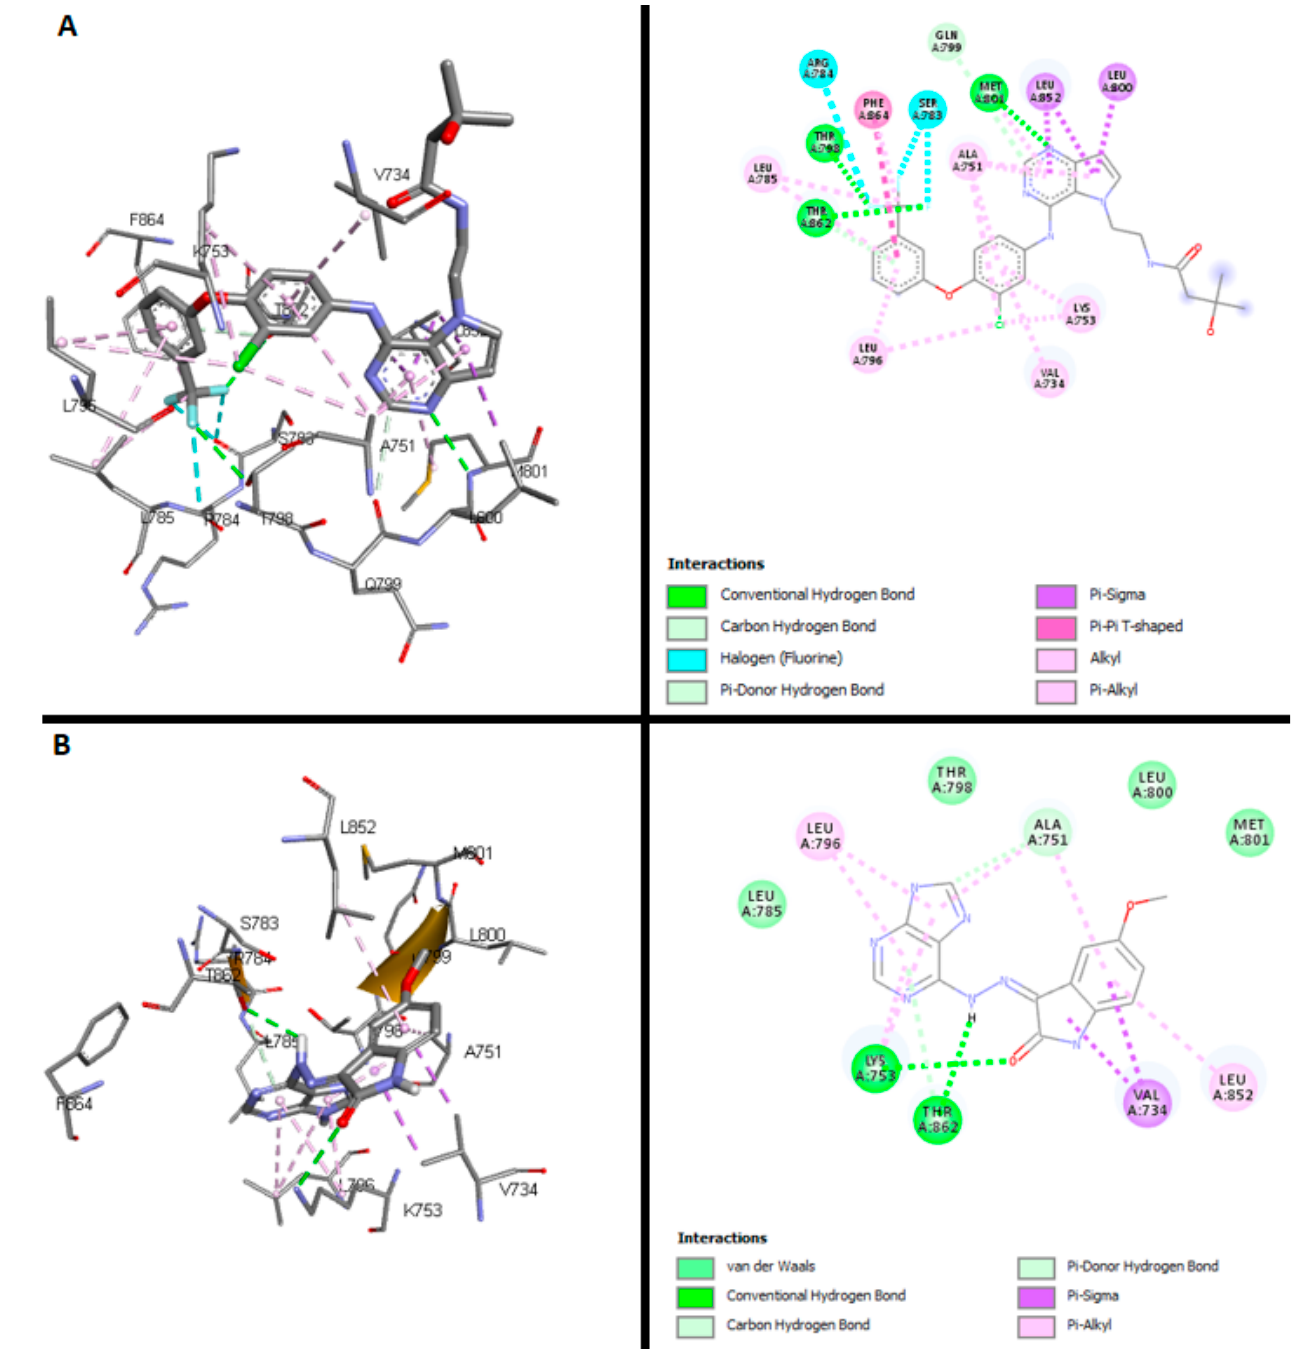
Figure 5. Schematic 2D and 3D representation of docking analysis of lapatinib ( A ) and compound 15 ( B ) in the active site of Her2 (PDB ID: 3RCD).